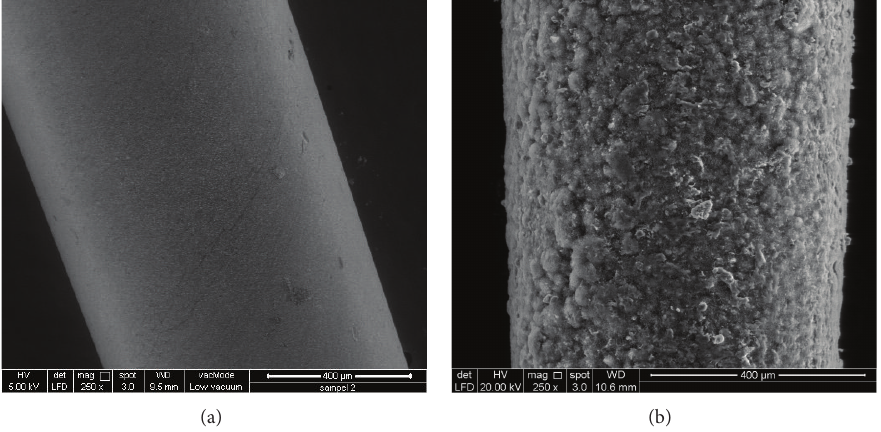
Figure 3: SEM morphological surface of (a) uncoated GP cone and (b) coated GP